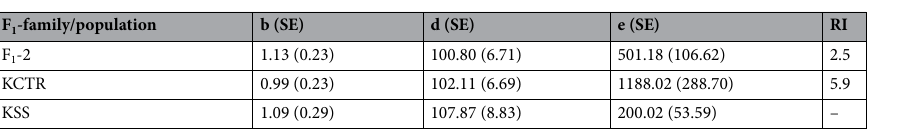
Table 2. Regression parameters describing the response of F 1 -2 progenies along with 2,4-D susceptible (KSS), resistant (KCTR) Palmer amaranth to 2, 4-D under growth chamber conditions (Eq. 2).